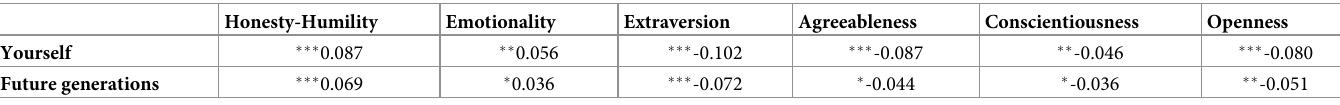
Table 6. Correlations between pre-intervention risk-averse attitudes toward IT innovations and HEXACO measures. Honesty-Humility Emotionality Extraversion Agreeableness Conscientiousness Openness Future